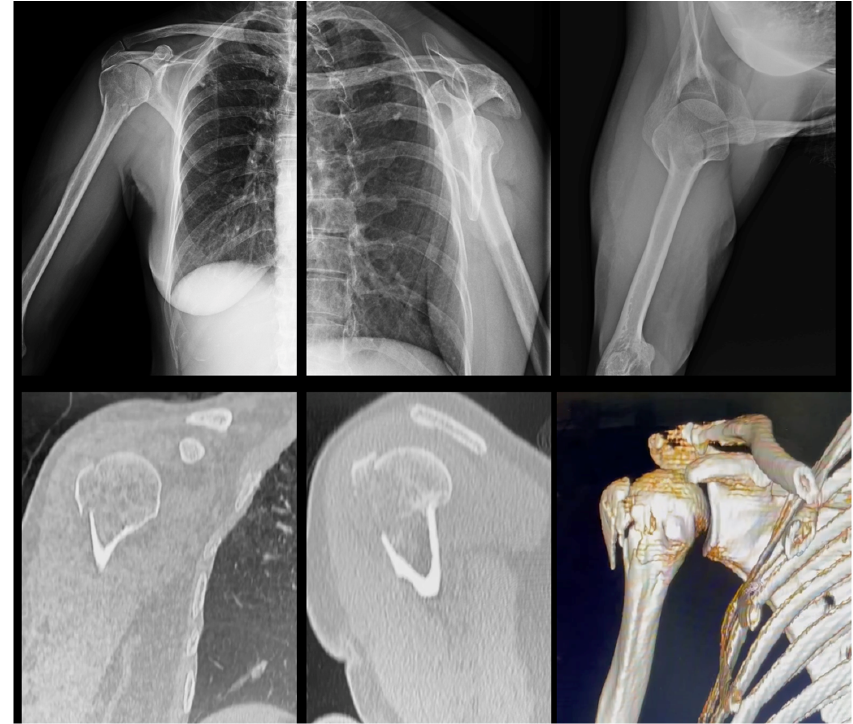
Figure 2. Radiographic and CT images of a 53 ‐ year ‐ old female patient with a right proximal humerus fracture (Case 2). Note that none of Hertel’s prognostic criteria is present in either of the two imaging exams. The fracture was classified as Neer 2 ‐ parts (greater tuberosity).